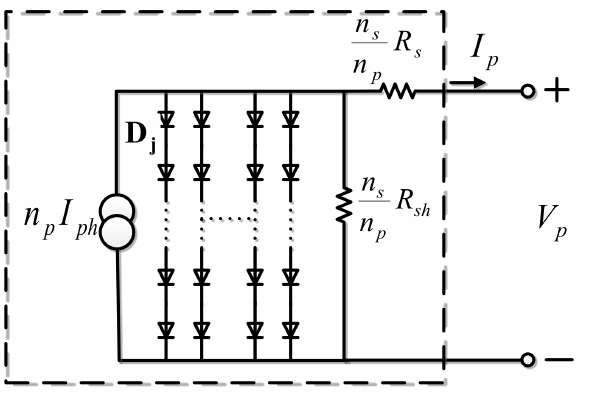
Figure 2. Equivalent circuit of a PV